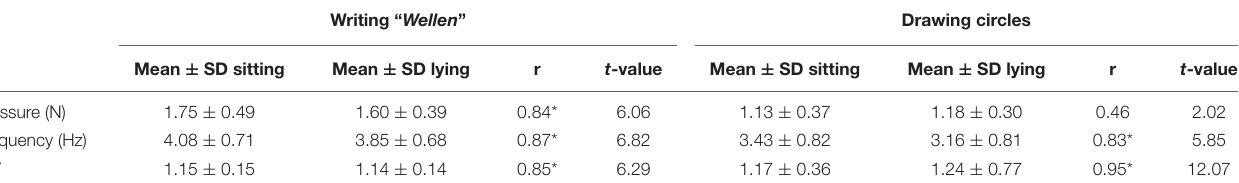
TABLE 1 | Parameter of the kinematic analysis for writing the German word “Wellen” or drawing circles in a sitting and in a horizontal position and the correlation between the conditions. Writing “ Wellen ” Drawing circles